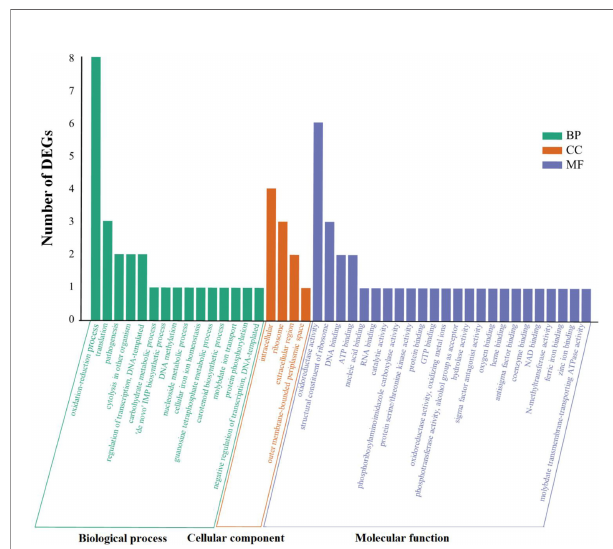
FIGURE 2 | All the GO terms enriched among the DEGs. Go databases were used to conduct GO functional annotation on the DEGs by R package GOseq v 1.18. All annotated determinants (x-axis) are divided into 3 GO domains: biological process (15 terms), molecular function (4 terms) and cellular component (24 terms). The y-axis suggests the number of DEGs. Green histogram stands for the biological process (BP), the orange histogram indicates cellular component (CC), and the purple histogram represents molecular function (MF). Differential expression pro fi les are acquired from DEGs in the wild-type and mutant strains, disclosing the impact of SprC on S . aureus metabolism, physiology and pathogenesis. GO, Gene Ontology; DEGs, differentially expressed